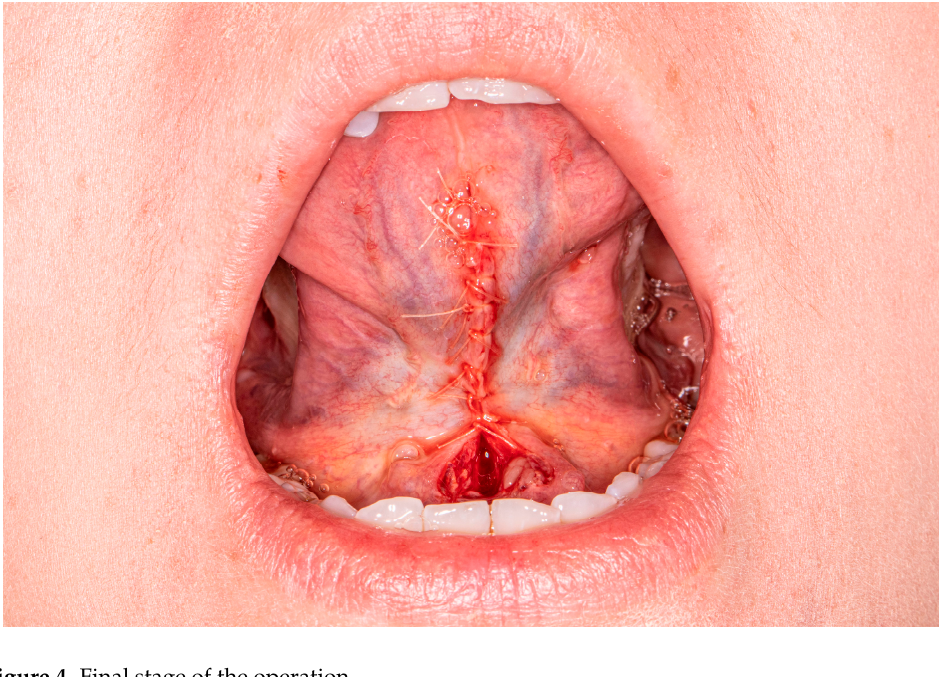
Figure 4. Final stage of the operation.